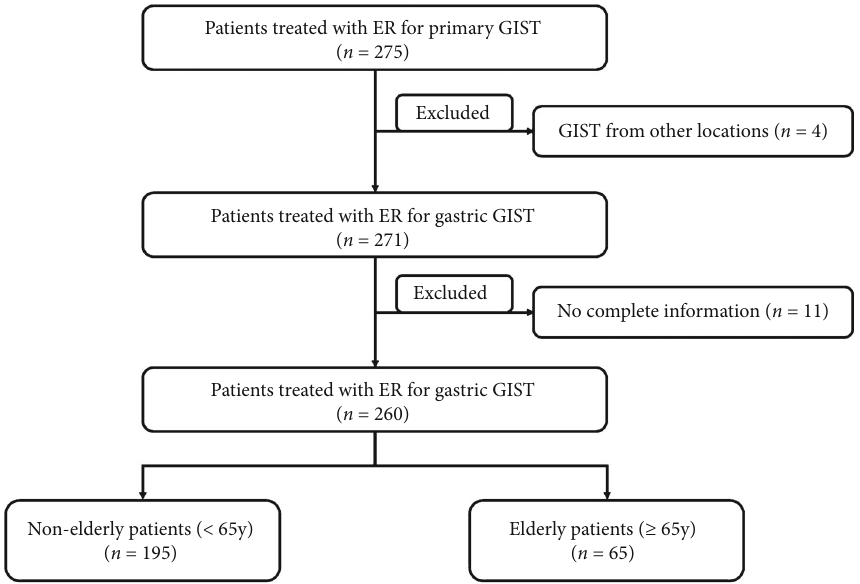
Figure 6: Study fl owchart for selection and grouping of patients with gastric gastrointestinal stromal tumors. GIST: gastrointestinal stromal tumor; ER: endoscopic